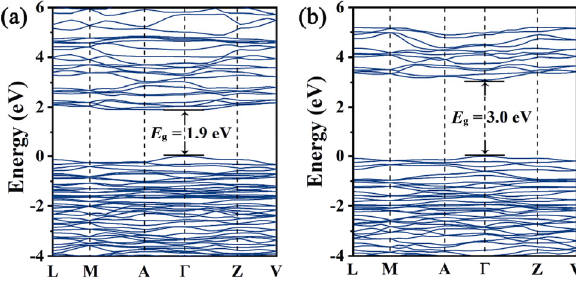
Fig. 8 Band structure of α -AgVO 3 along the high symmetry line in the Brillouin zone calculated by (a) GGA and (b) HSE03